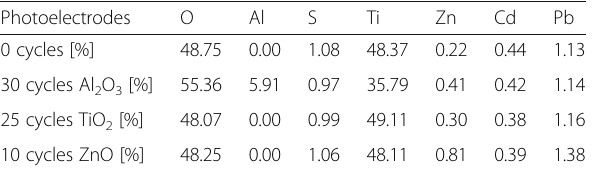
Table 1 Atomic percentages of the elements derived in EDS spectra